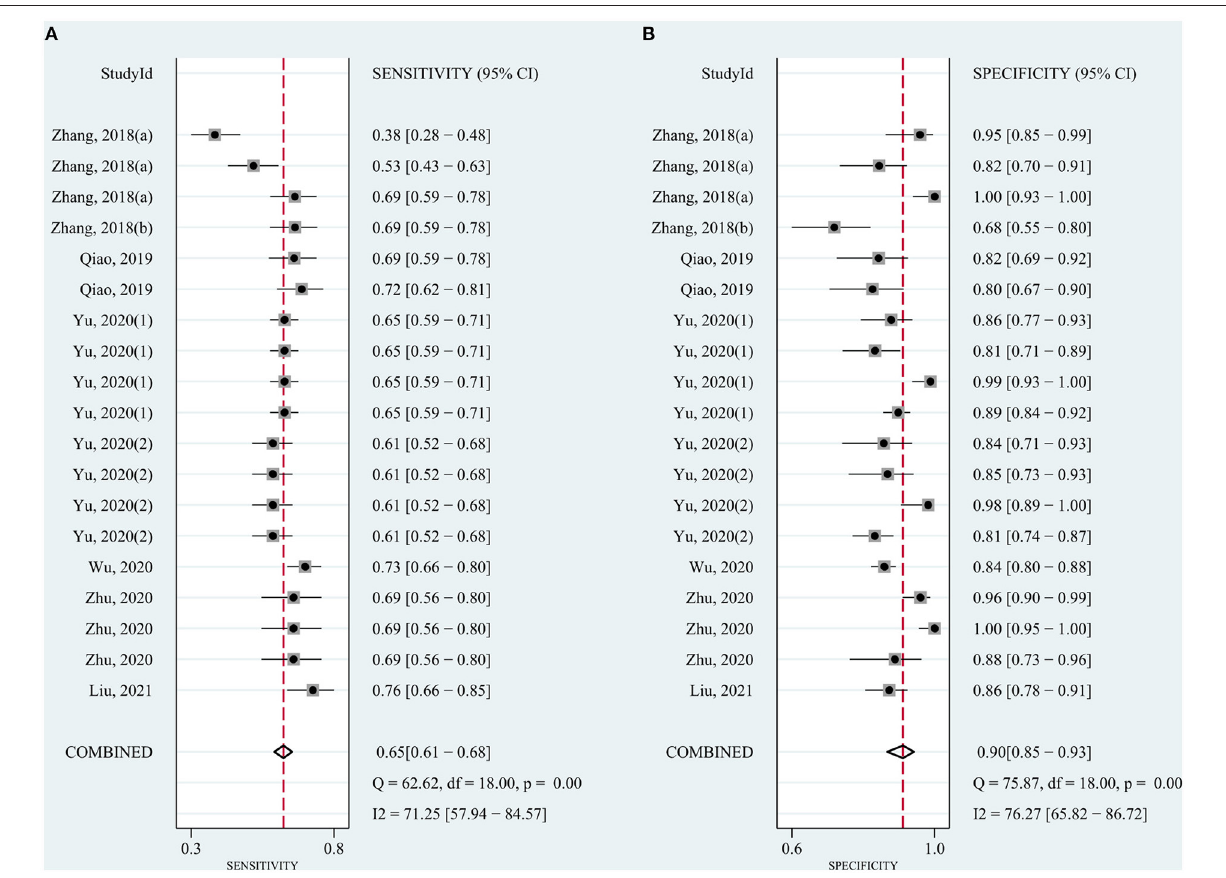
Subgroup Analysis of HCC vs. Cirrhosis